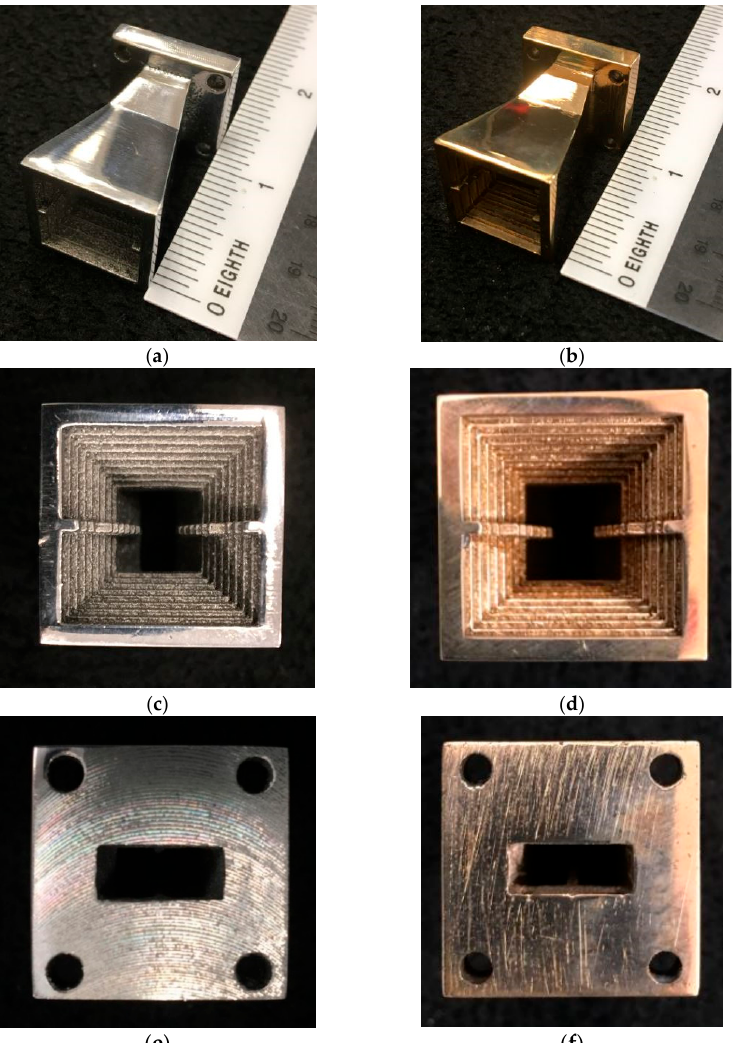
Figure 2. Photographs of the 3D-printed, K-band-stepped, double-ridged square horns. The aluminium alloy horn: ( a ) outlook; ( c ) aperture view; ( e ) flange view. The copper horn: ( b ) outlook; ( d ) aperture view; ( f ) flange view.